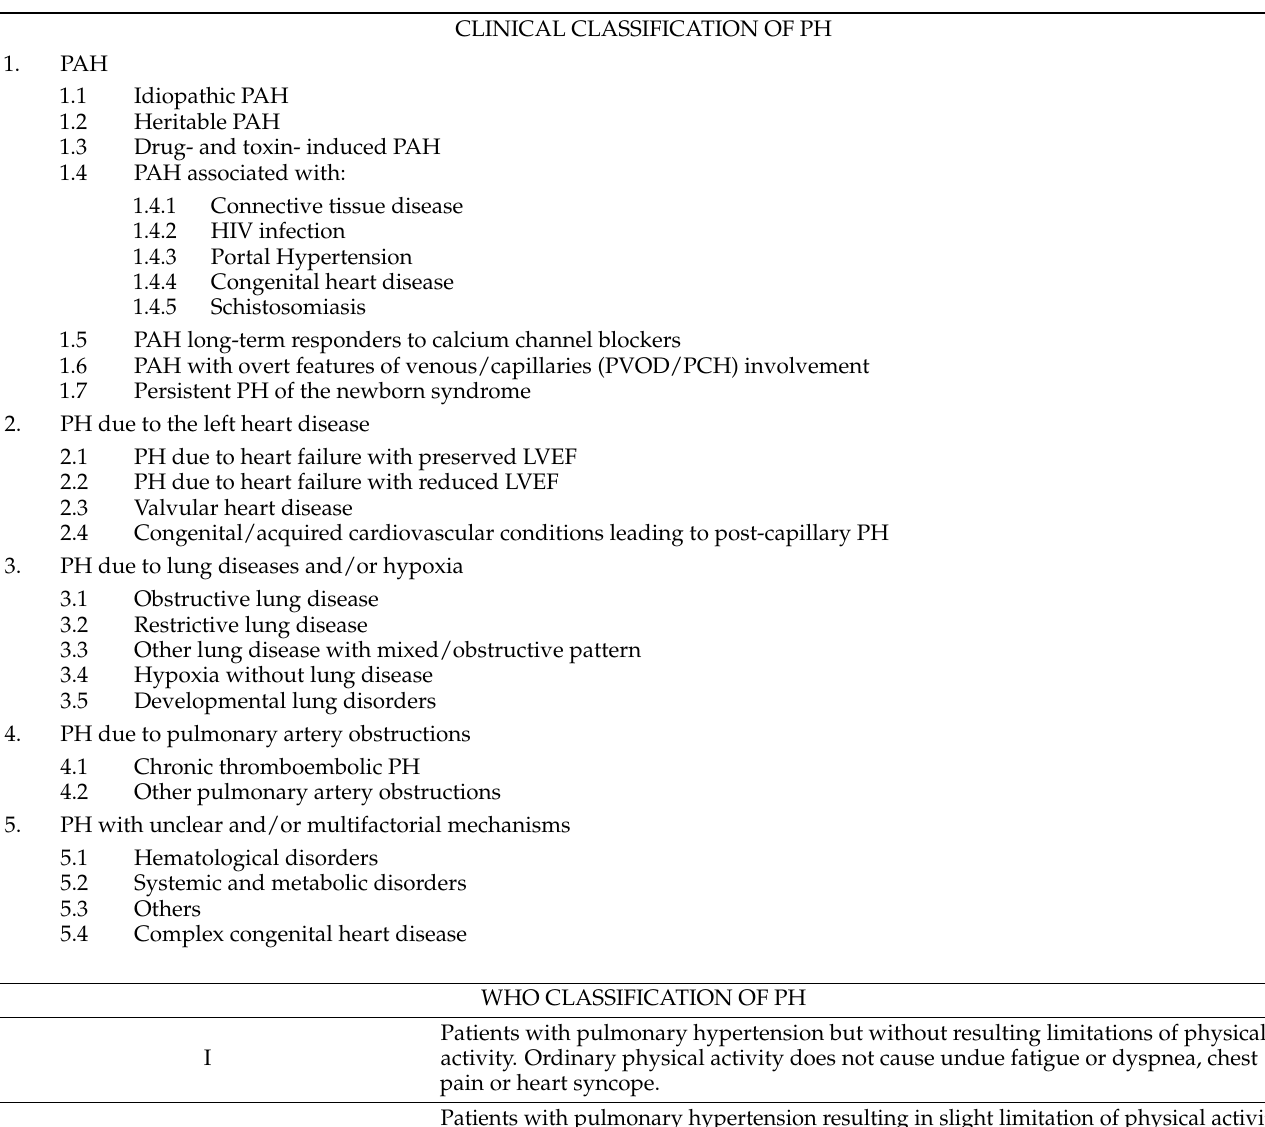
Table 2. Classification of pulmonary arterial hypertension (Modified and adapted from Simon- neau et al., 2019 [30], Tang et al., 2016 [32]). PH—pulmonary hypertension,